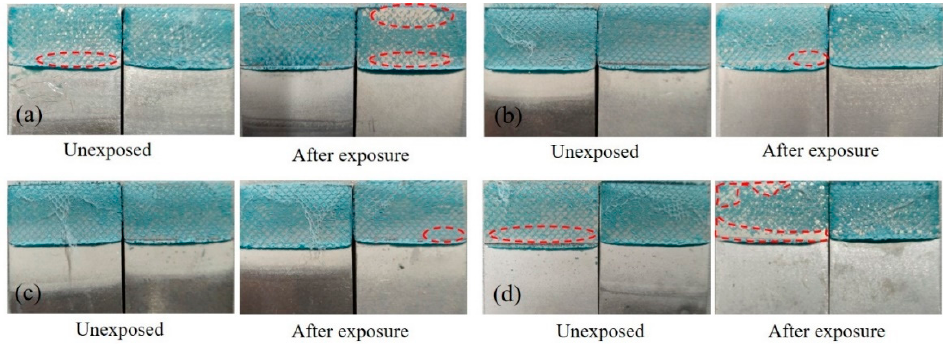
Figure 11. Effect of surface roughness by combined treatment on failure modes after exposure: ( a ) process 1, ( b ) process 2, ( c ) process 3, and ( d ) process 4.